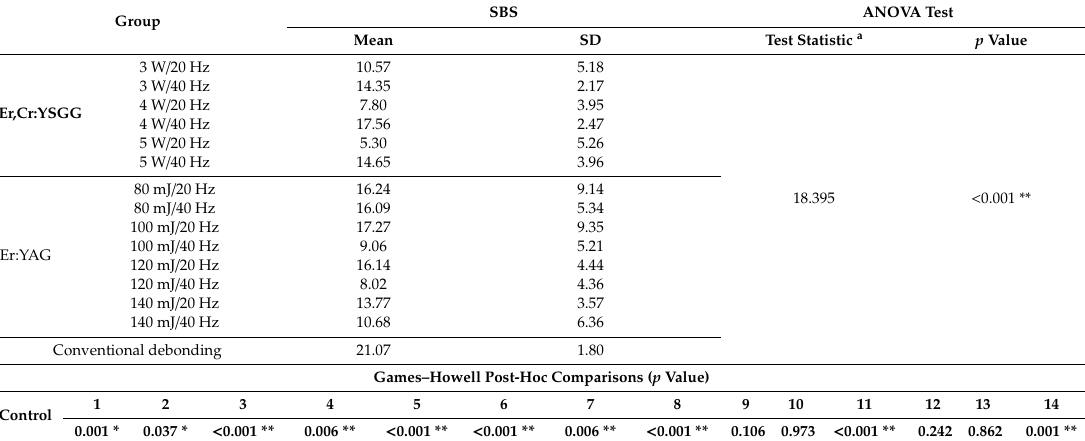
Table 5. Distribution of SBS by various test groups (n = 180). ANOVA—analysis of variance. Group SBS ANOVA Test Mean SD Test Statistic a p